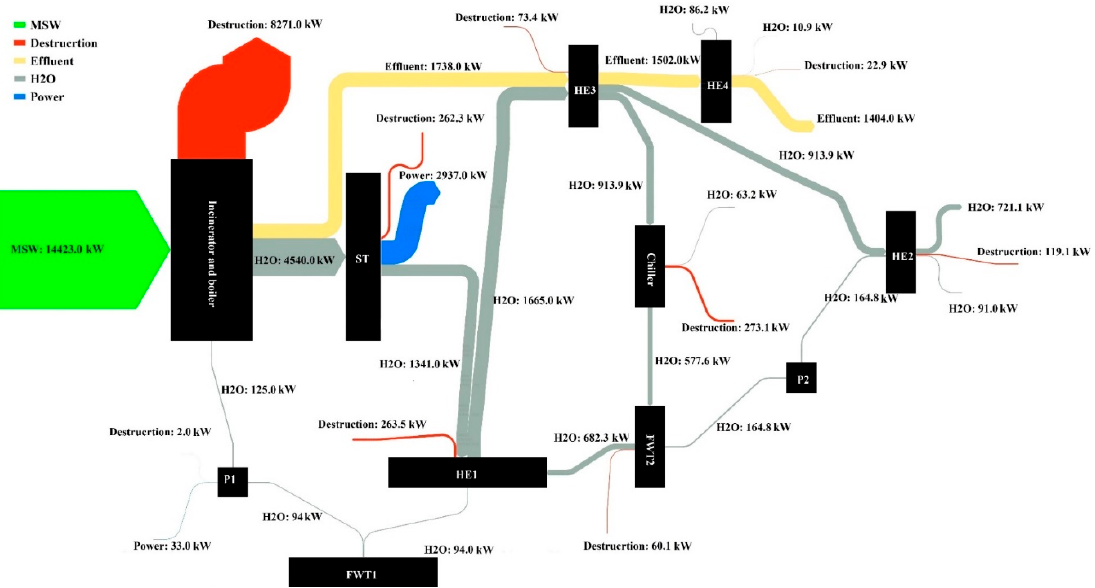
Figure 2. Exergy flow diagram of the proposed CCHP system.